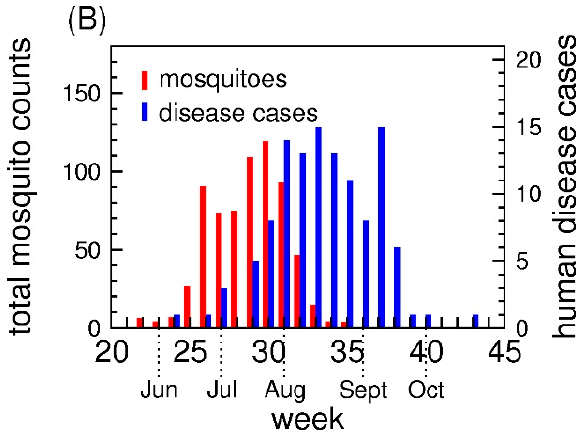
Figure 2. The incidence of human disease cases of West Nile Virus in Burleigh County and mosquito numbers in Bismarck. Panel ( A ) shows the averaged yearly total of Culex tarsalis mosquitoes per trap and the yearly total of human disease cases. The mosquito numbers represent the total mosquito numbers from all traps divided by the total number of traps operated each year. Total number of human disease cases are the numbers of patients diagnosed with WNV each year; Panel ( B ) displays the averaged weekly total numbers for Culex tarsalis mosquitoes and human disease cases from 2007 to 2016. The mosquito counts were calculated by aggregating trap data for the same week of the year and dividing this sum by the total number of traps. The disease cases were aggregated for the same weeks of the year. The red bars indicate the total number of mosquitoes counted while the blue bars are the total number of human disease cases.